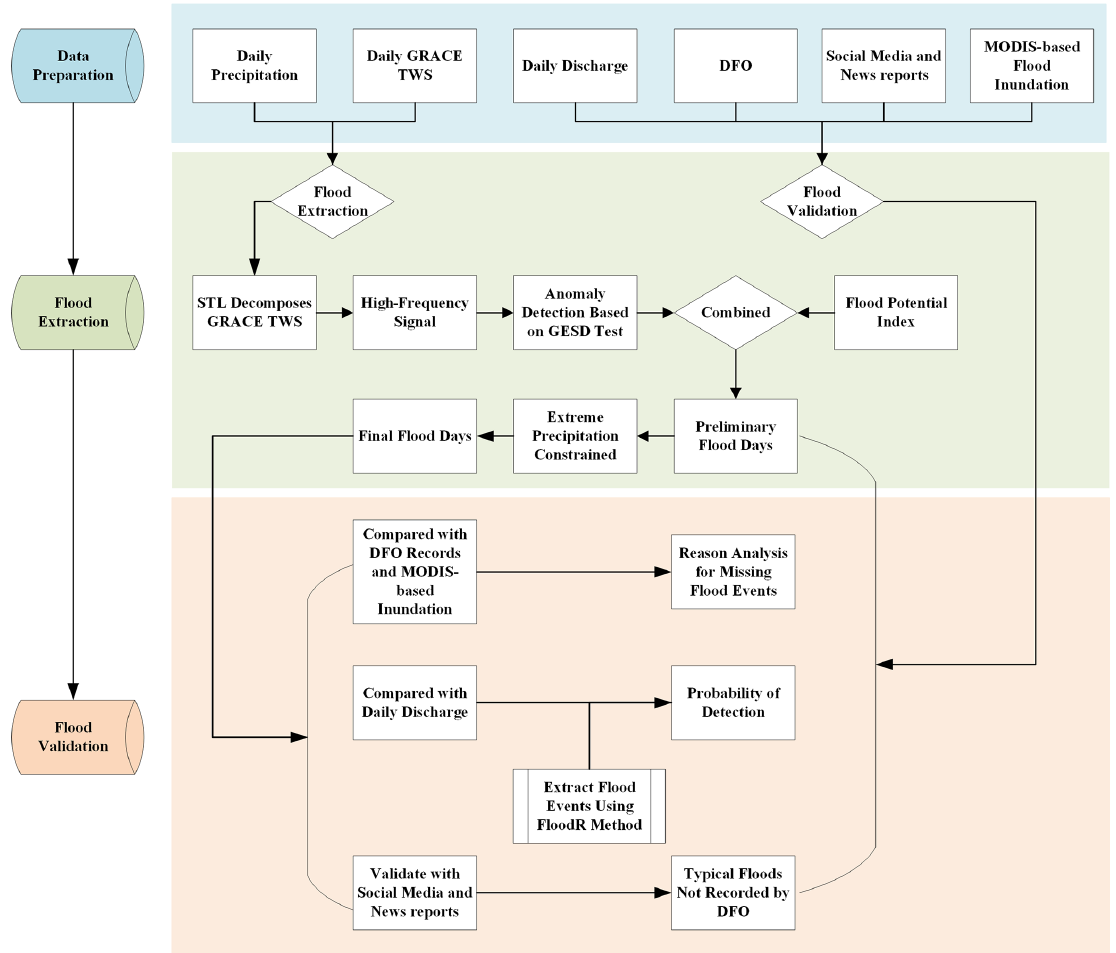
Figure 1. Workflow of the global flood extraction approach based on GRACE and precipitation